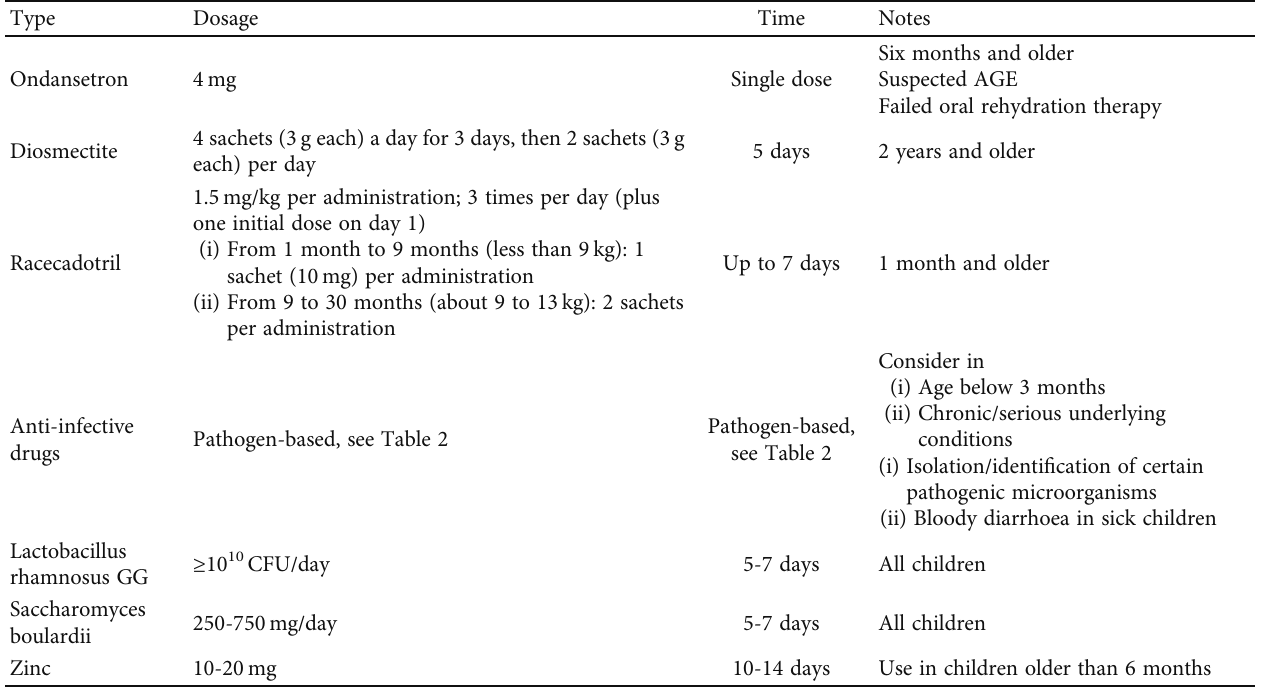
Table 3: Pharmacological options as adjunct treatment to ORS for the management of paediatric AGE in Jordan.